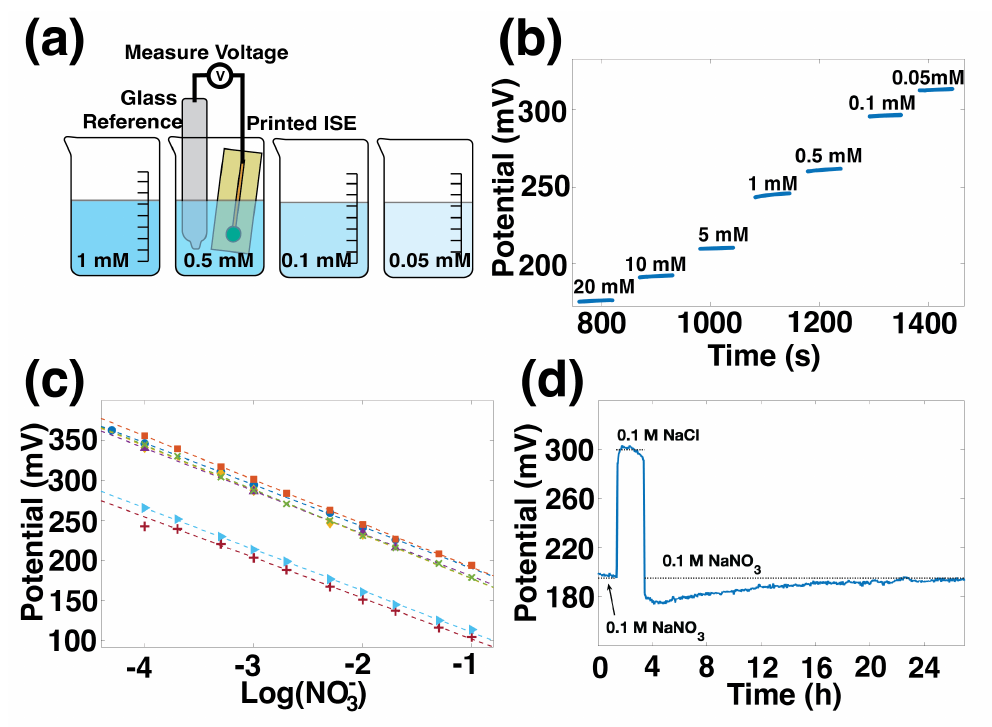
Figure 2. ( a ) Characterization of a printed nitrate-selective electrode against a commercial refer- ence electrode in NaNO 3 solutions of varying concentrations. ( b ) Potential over time response of a printed nitrate-selective electrode in changing concentrations of nitrate. ( c ) Sensitivity plot of 7 nitrate-selective electrodes overlaid, showing good repeatability and near-Nernstian response of − 54.1 ± 2.1 mV/dec. ( d ) Water layer test showing the stability of the nitrate-selective electrode. In Figure 2c, the sensitivity curves for different sensors are offset one from